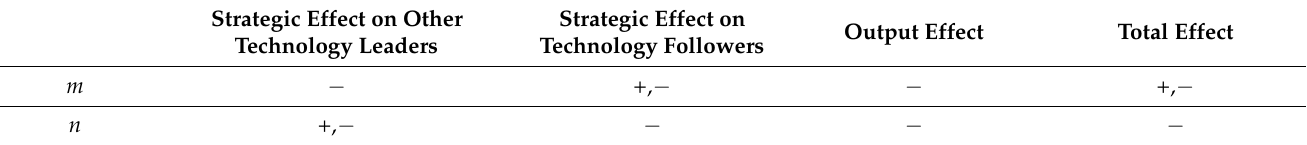
Table 1. The impact of the number of firms on individual R&D